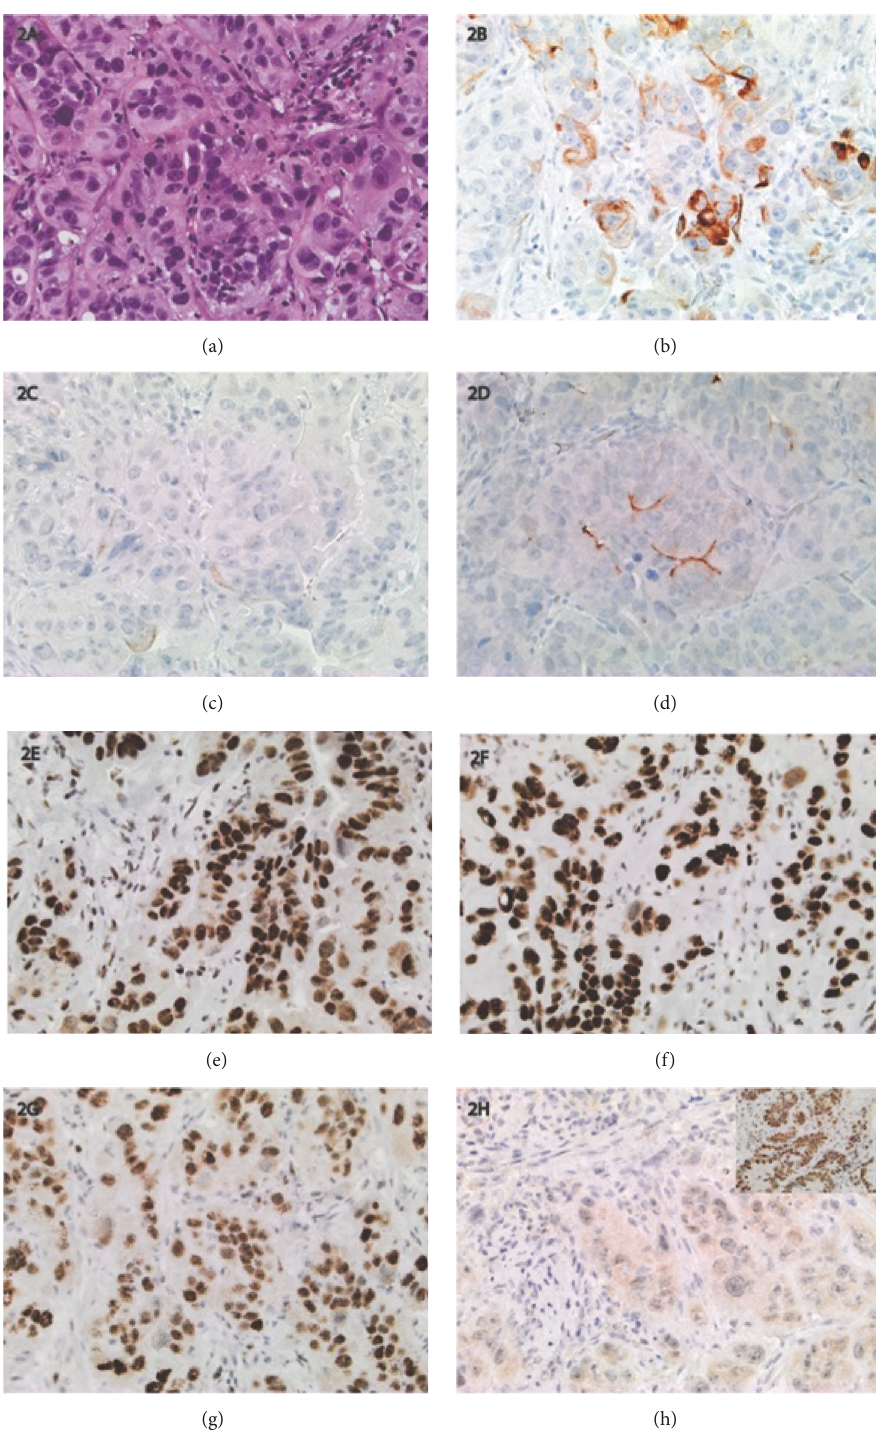
Figure 2: Immunohistochemicalstudies for PMS2 deficient adenocarcinoma,40X. (a) H&E: moderatelydifferentiated adenocarcinomawith crowded glands and minimal stroma. (b) CK7: focal positive immunostaining for CK7. (c) CK20: negative immunostaining for CK20. (d) Villin: focal minimal superficial (brush border) immunostaining for villin. CDX2 was also focally positive (not shown). (e) MLH1: intact nuclear immunostaining for MLH1 (no loss of expression). (f) MSH2: intact nuclear immunostaining for MSH2 (no loss of expression). (g) MSH6:intactnuclearimmunostaining for MSH6(noloss of expression). (h)PMS2: loss ofnuclearimmunostaining for PMS2inboth tumoral cells and background lymphocytes. Positive tissue control stains were appropriately positive